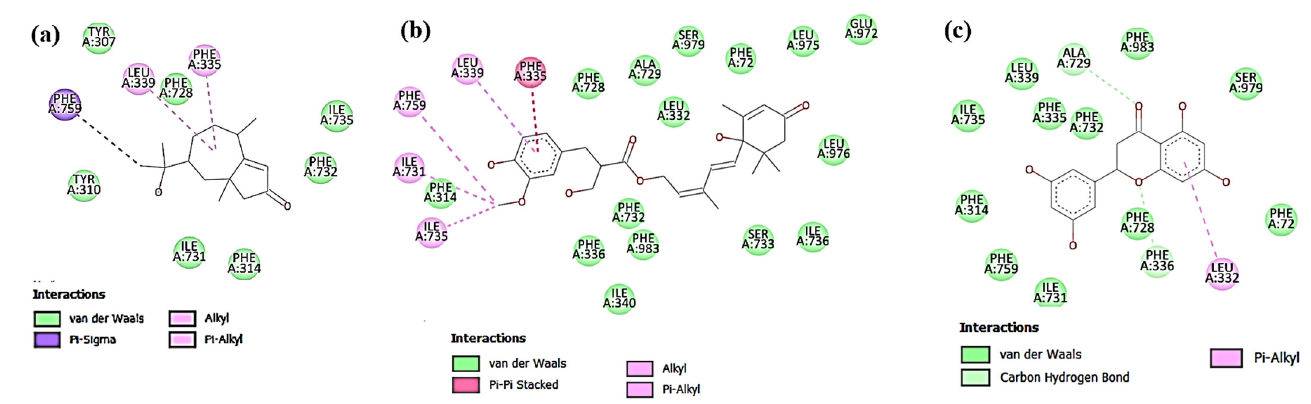
Figure 8. Two-dimensional (2D) molecular interactions of ( a ) Compound C3 ; ( b ) Compound C5 ; and ( c ) Compound C7 with the crystal structure of human P-gp (PDB ID: 6C0V), (dimensions (Å) X:20.8191, Y:24.1576, Z:27.1117), (root mean square deviation) RMSD < 2. Width 995, (root mean